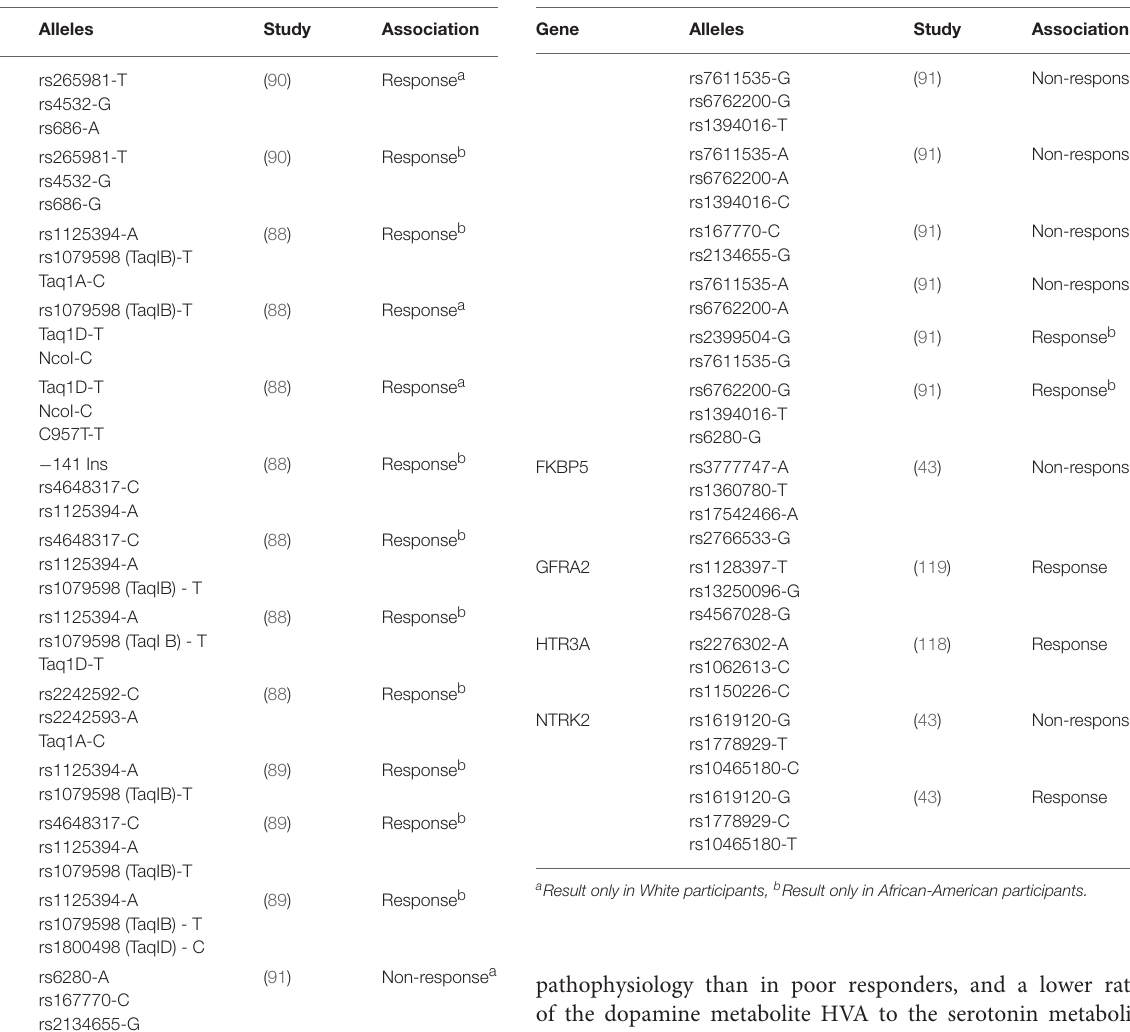
TABLE 10 | Significant findings for